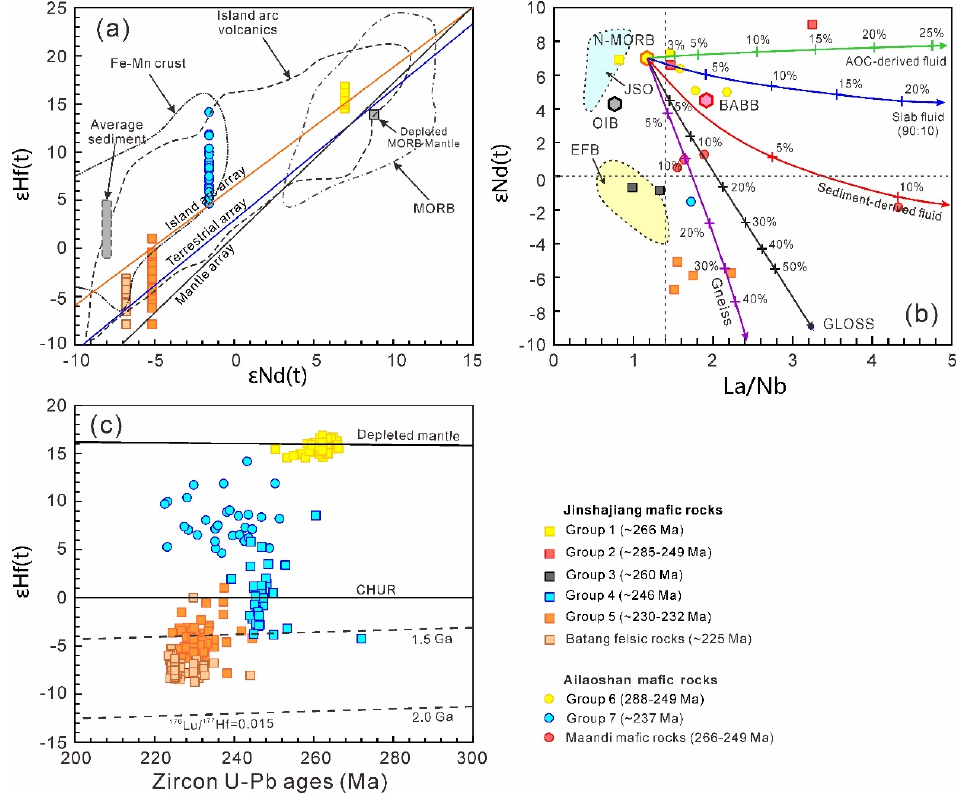
Figure 8. ( a ) ε Nd(t) vs. ε Hf(t) diagram, ( b ) La/Nb vs. ε Nd(t) diagram [25], and ( c ) age vs. ε Hf(t) diagram of the Jinshajiang and Ailaoshan mafic and felsic rocks. Data sources: The trace element contents and the average ε Nd ( − 8) value of Global Oceanic Sediments (GLOSS) are from Plank and Langmuir [105], N-MORB are from Sun and McDonough [98] and Chauvel et al. [106], Back-arc Basin Basalts (BABB) are from Fan et al. [48], OIB are from Sun and McDonough [98] and La Flèche et al. [107], Emeishan Flood Basalts (EFB) are from Xiao et al. [108], and Jinshajiang ophiolites (JSO) are from Xu and Castillo [10]. Island arc array ( ε Hf = 1.23 × ε Nd + 6.45) and mantle array ( ε Hf = 1.59 × ε Nd + 1.28) are from Su [109] and Chauvel et al. [106], respectively, and Terrestrial array ( ε Hf = 1.36 × ε Nd + 2.95) is from Vervoort et al. [110].